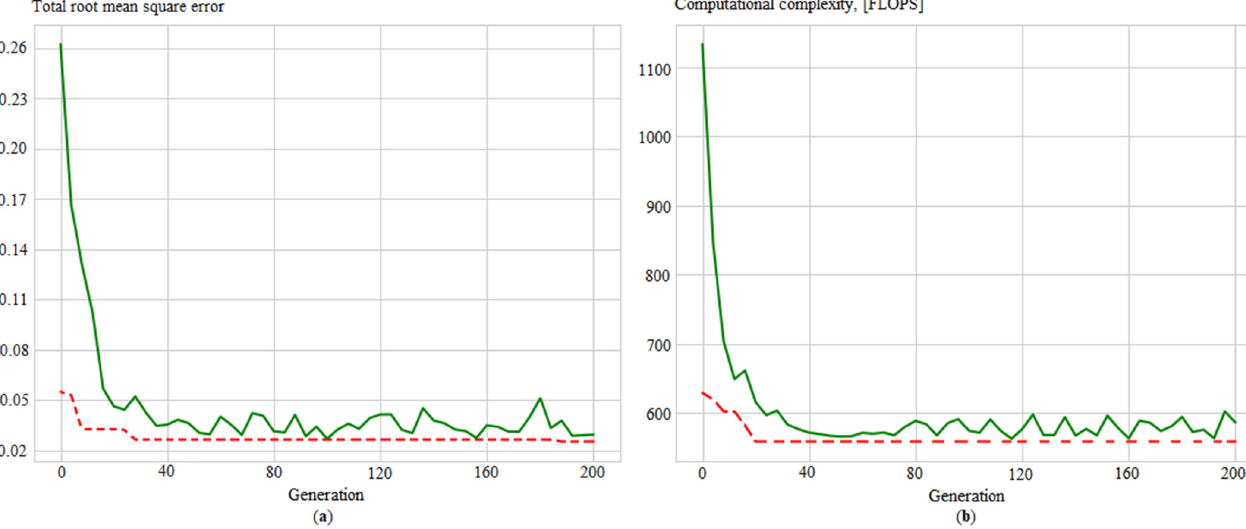
Figure 13. Evolution of the ANN corr in the process of determining its best structure by ( a ) total root mean square error; ( b ) computational complexity, where solid green lines are average values per generation, and dotted red lines are minimum values per generation.